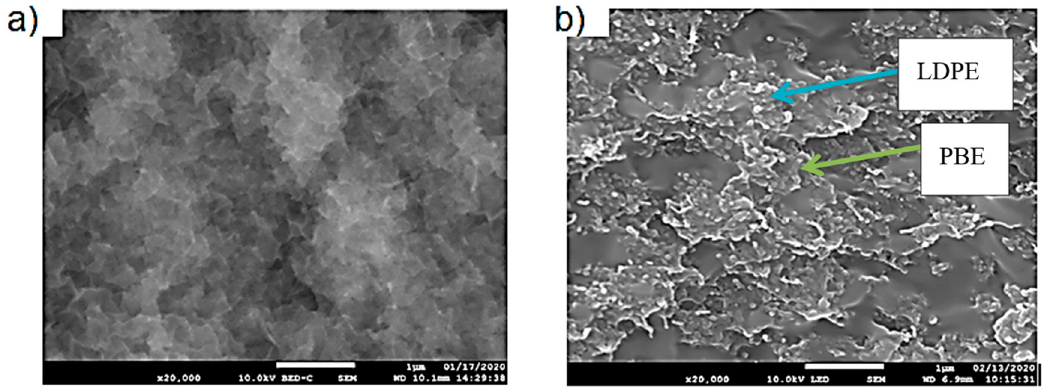
Figure 17. SEM images of the 80 ( LDPE KB 12.5 CNT 3.1 ) /20PBE to obtain globally in the blend 10% KB and 2.5% CNT. The images ( a , b ) represent the cross section and longitudinal views, respectively, of the blend using two-step extrusions. LDPE is whiter and the PBE is